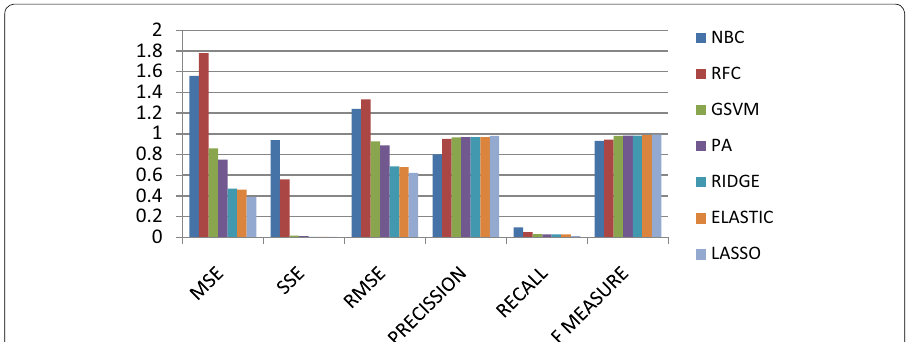
Fig. 6 Performance metrics for different classifiers under PRIVATE database